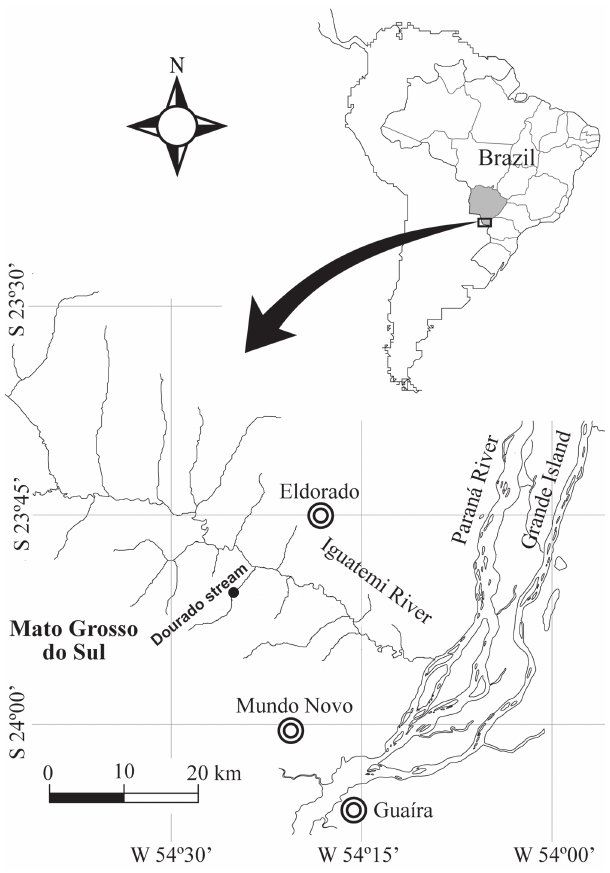
Fig. 1. Location of Dourado stream in the upper Paraná River basin where Gymnorhamphichthys britskii individuals were captured. The dark circle indicates the sampling